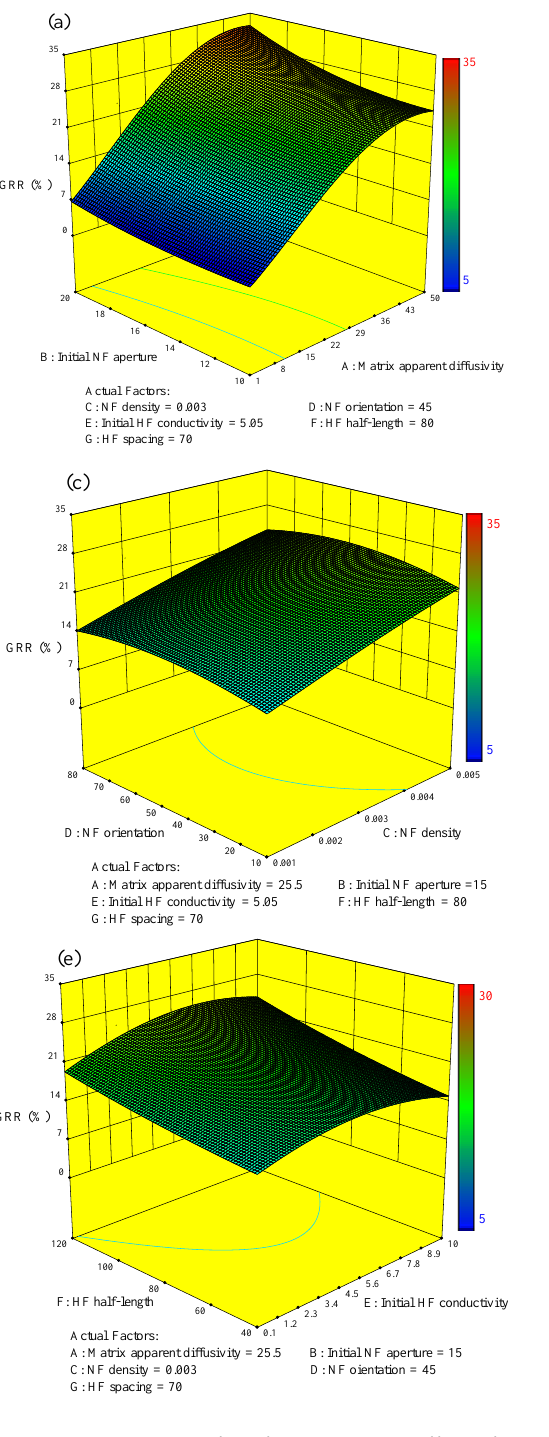
Figure 13. 3D surface for interaction effect of two-parameter on long-term GRR response at fixed values of other parameters (( a ) Influence of matrix apparent diffusivity and initial NF aperture on GRR ; ( b ) Influence of initial NF aperture and NF density on GRR ; ( c ) Influence of NF density and NF orientation on GRR ; ( d ) Influence of NF orientation and initial HF conductivity on GRR ; ( e ) Influence of initial HF conductivity and HF half-length on GRR ; ( f ) Influence of HF half-length and HF spacing on GRR ).